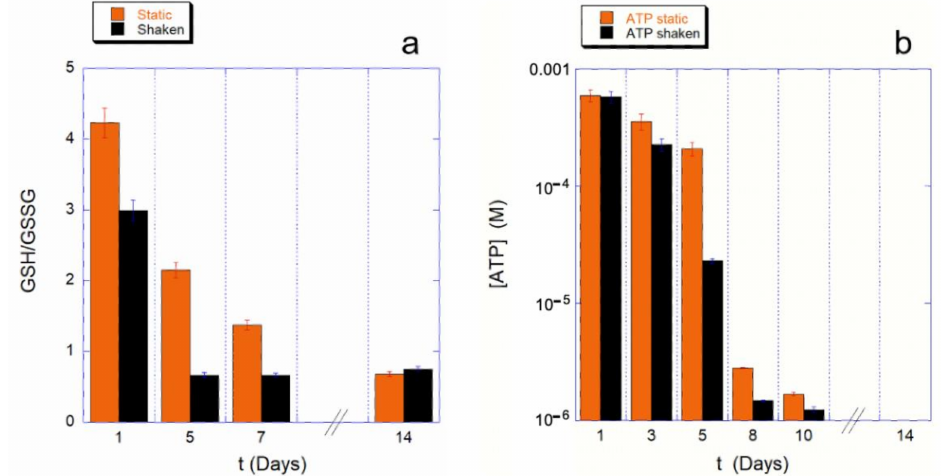
Figure 2. Histograms reporting the GSH/GSGG ratio ( a ) and the intracellular ATP content ( b ) for static (orange bars) and mechanically stimulated (black bars) samples. The energy consumption is higher in the shaken samples with respect to the static ones. In terms of reducing power, this difference is significant already after 1 day of ageing, while in the ATP trend, this difference becomes evident after 4 days of ageing. The ATP concentrations are shown in log